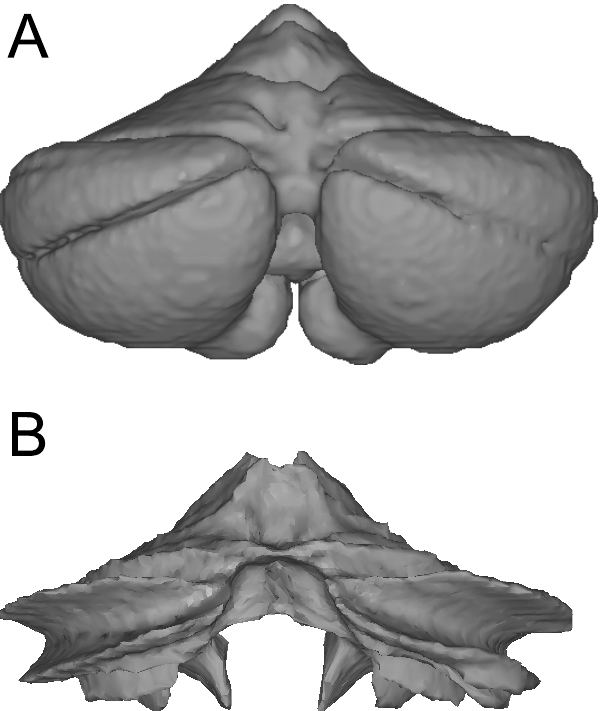
Fig 2. Surfaces defined on a group-averaged anatomical template image of the human cerebellum. ( A ) The outer surface constitutes a hull around the average grey matter body. ( B ) The inner surface is placed on the boundary between average white and grey